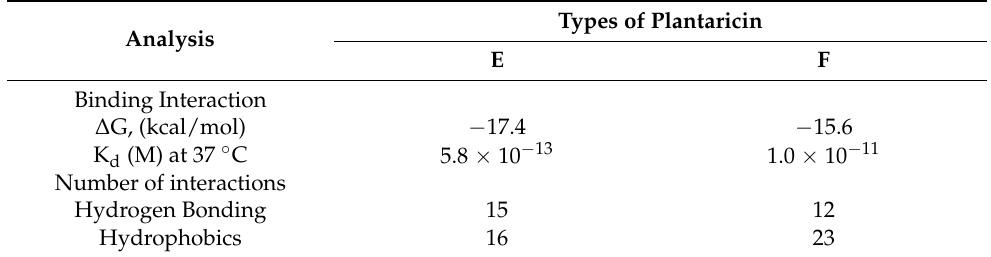
Figure 7. Molecular Docking of PlnE and PlnF. ( a ) The 3D structure of SARS-COV-2 helicase nsp 13 (PDB ID: 6ZSL) was used in the molecular docking studies. The built model for PlnE ( b ) and PlnF ( c ). The docked results shown that PlnE ( d ) and PlnF ( e ) were tucked into both the ss-RNA and the ATP binding site cavity. Table 3. Summary of molecular docking result, number of interactions involved for PlnE and